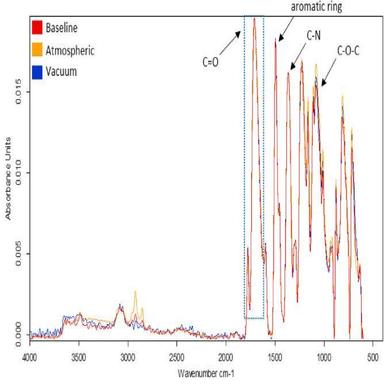
Ftir data of baseline, atmospheric, vacuum polyimide insulations.